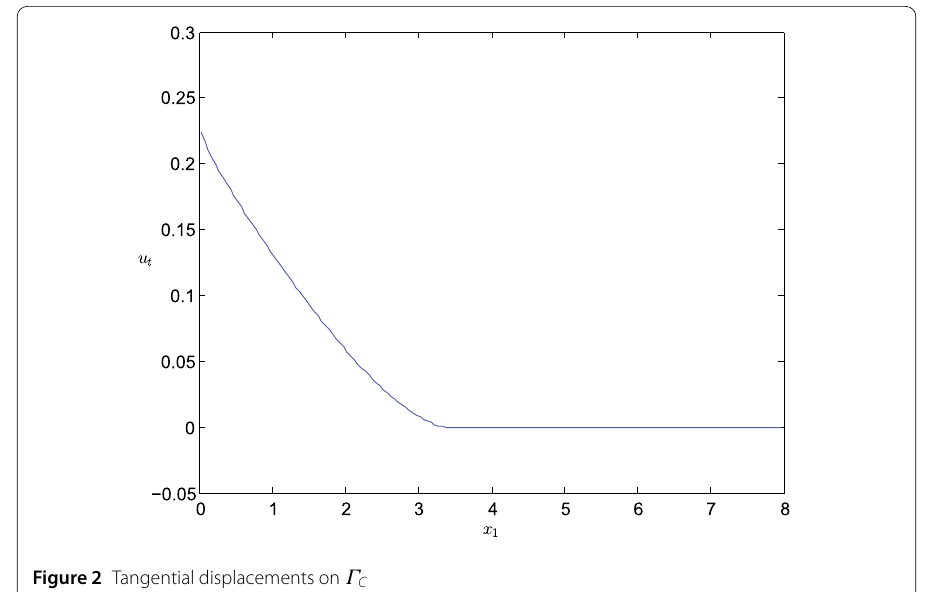
Figure 2 Tangential displacements on Γ C